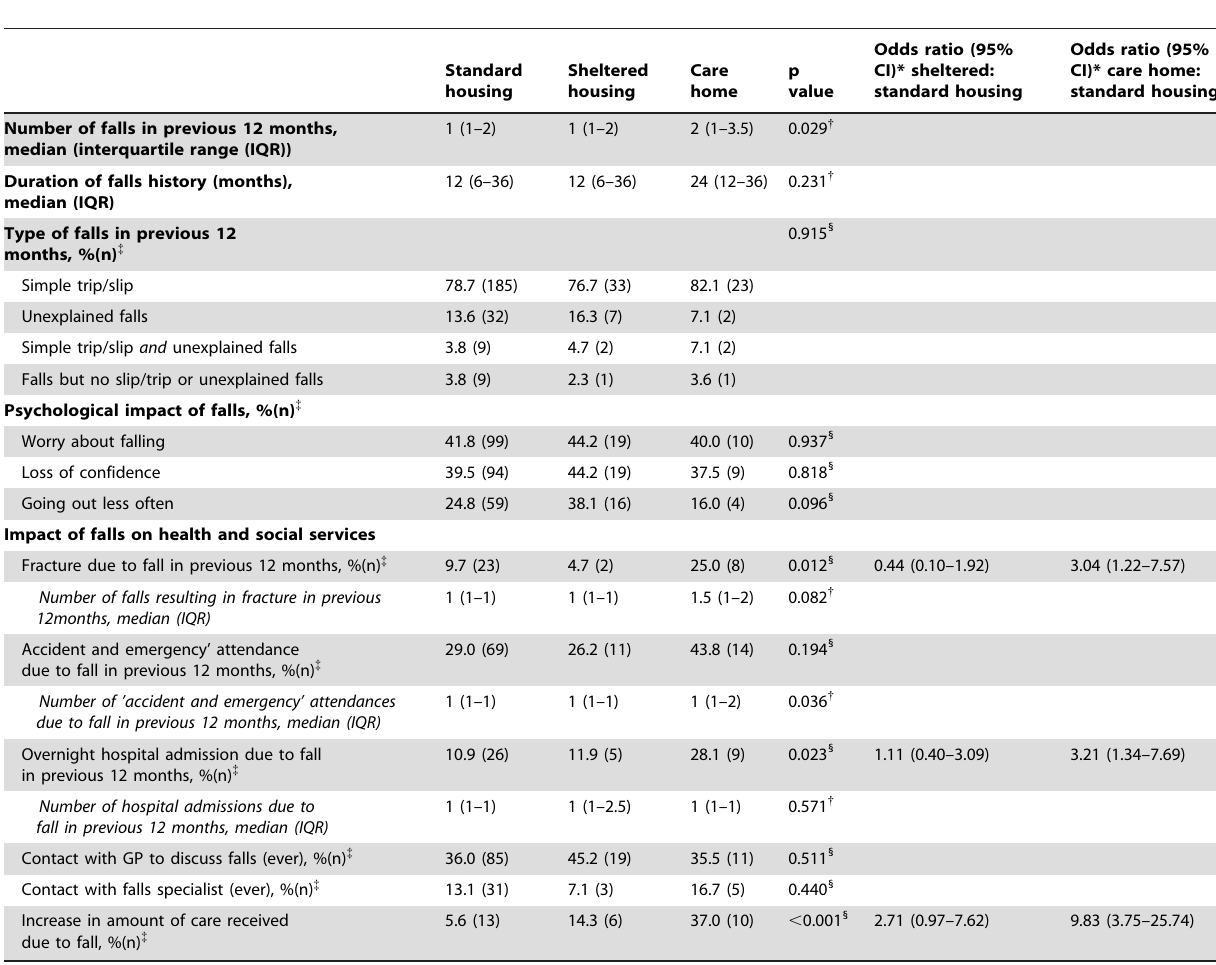
Table 2. Falls: number, duration of history, sub-types, psychological impact and impact on health and social care services - reported for those who had fallen in the previous 12 months, by type of